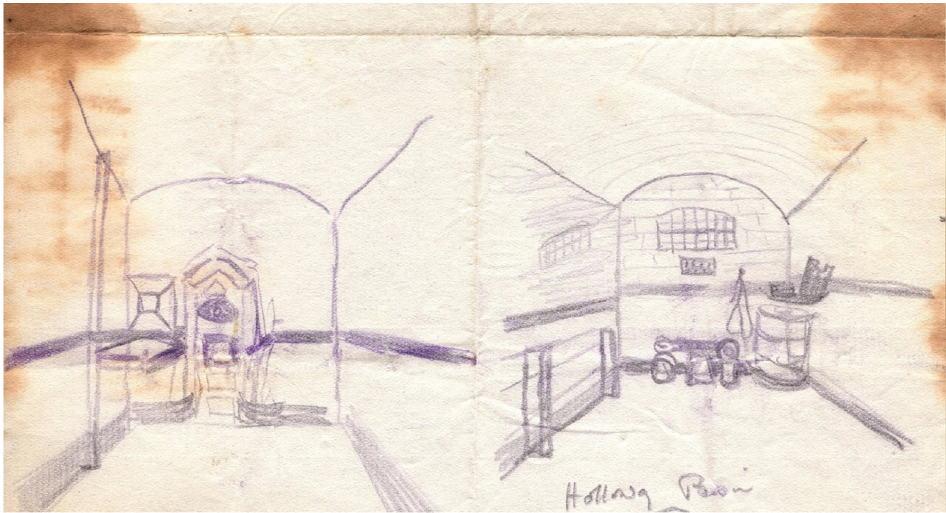
Figure 5. Vera Holme’s sketch of her solitary confinement in Holloway Prison which she hid in her pocket diary throughout her incarceration, Vera Holme Papers, Women’s Library, LSE, London .